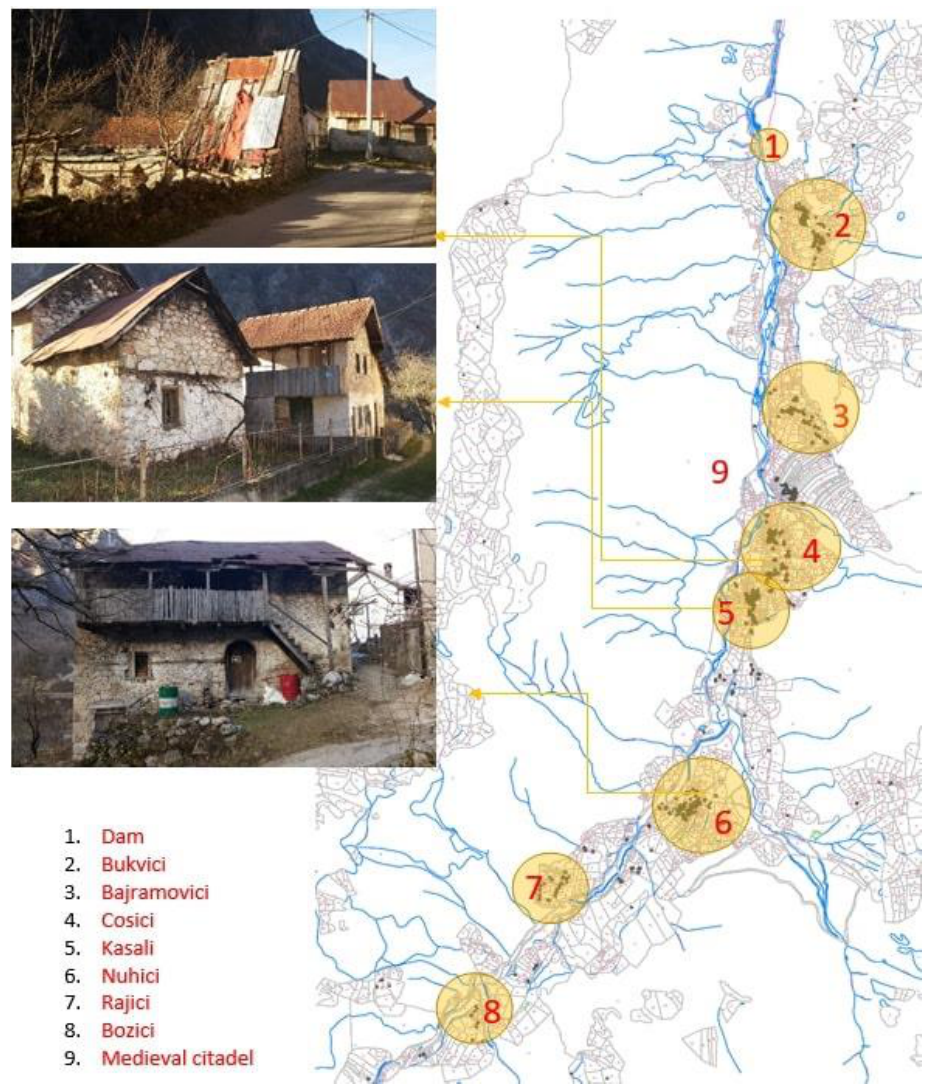
Figure 3. Structure of the village Idbar with its hamlets (Source: